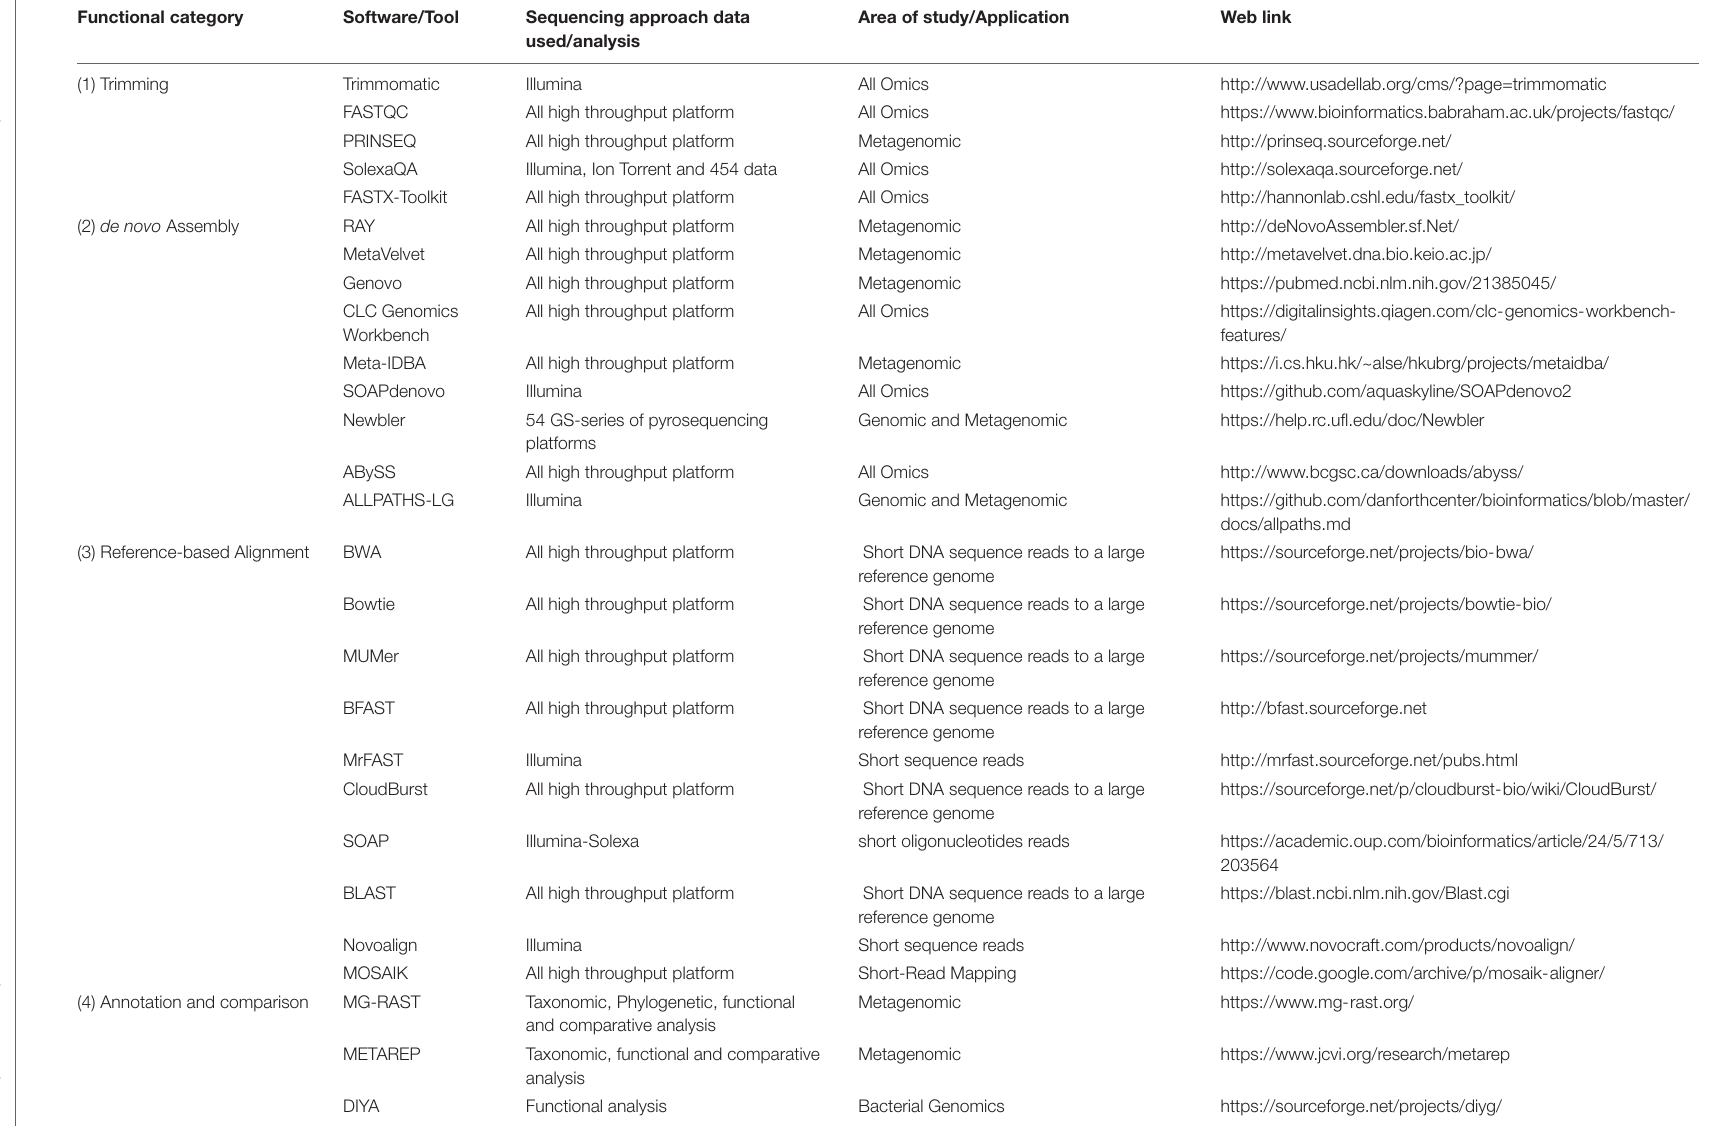
TABLE 2 | Software tools and algorithms in metagenomics and its association studies. Functional